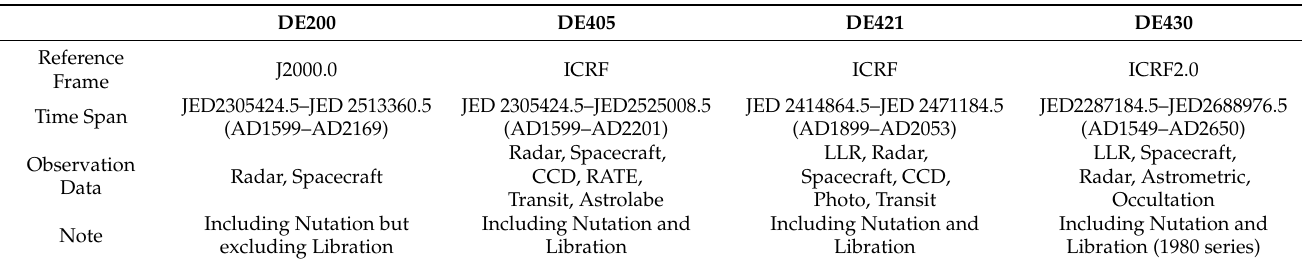
Table A1. Basic introduction of four ephemerides.